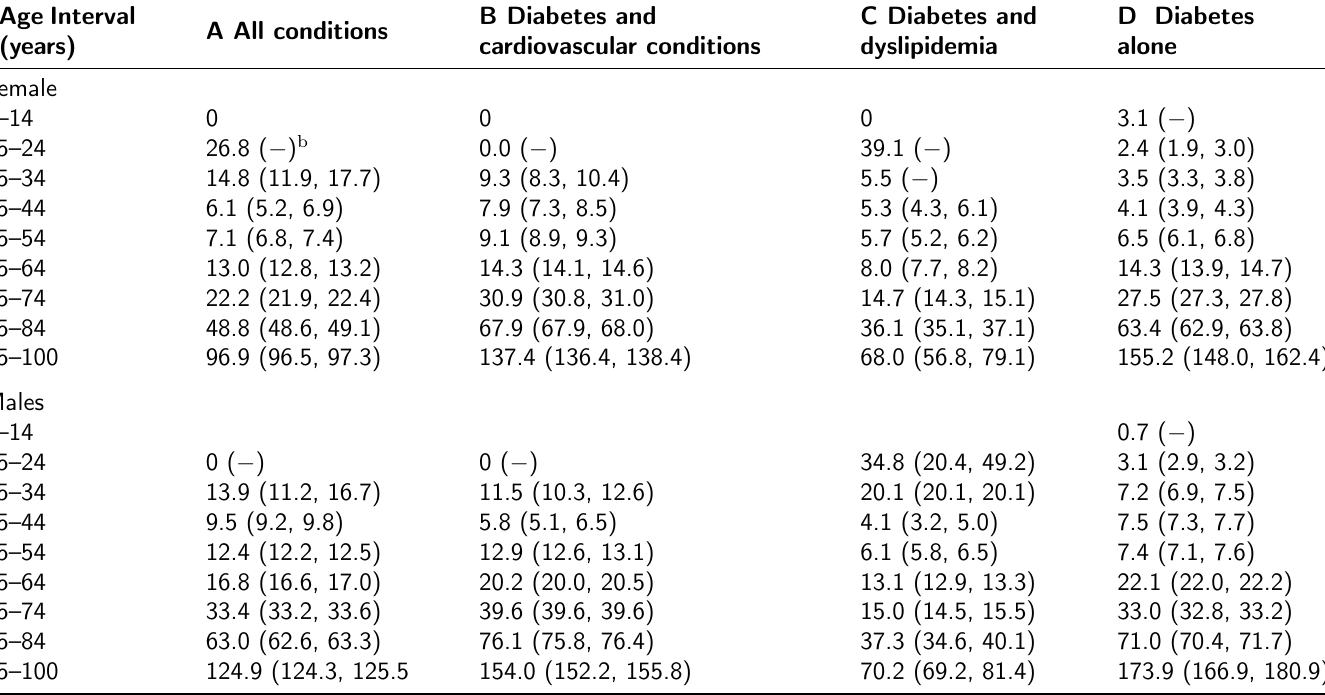
Table 3: Age specific mortality rates (95%CI) for females and males with diabetes associated multi-morbidities in